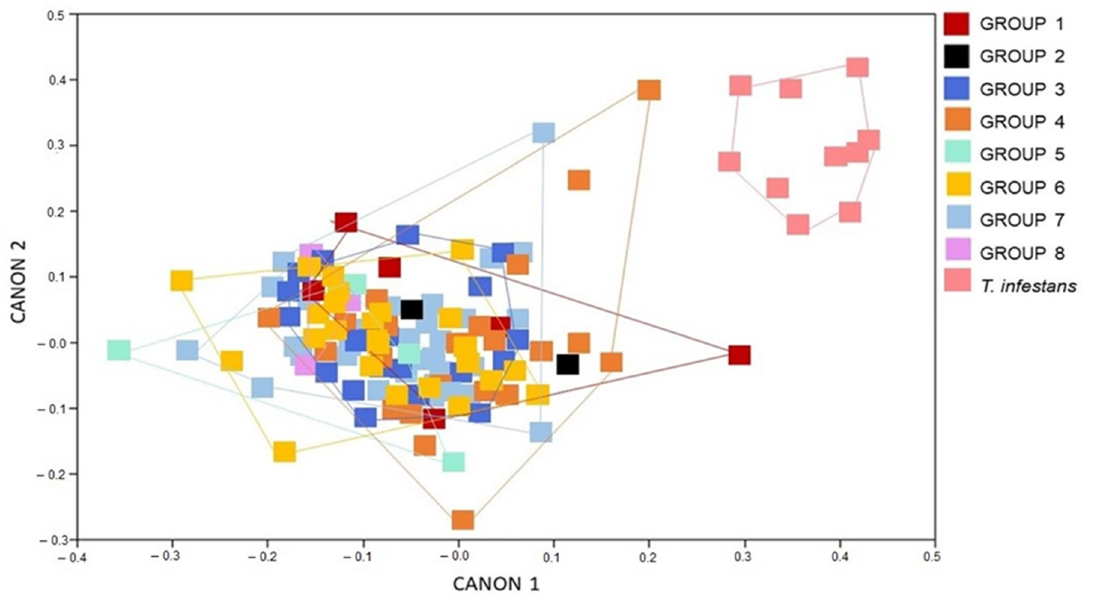
Figure 8. Canonical variate analysis showing the conformation influence in males and females of Triatoma brasiliensis brasiliensis from several states and years (1912–2014). Groups: 1, 2, 3, 4, 5, 6, 7, 8, and an external group T. infestans Canon represents the canonical variate dimension.